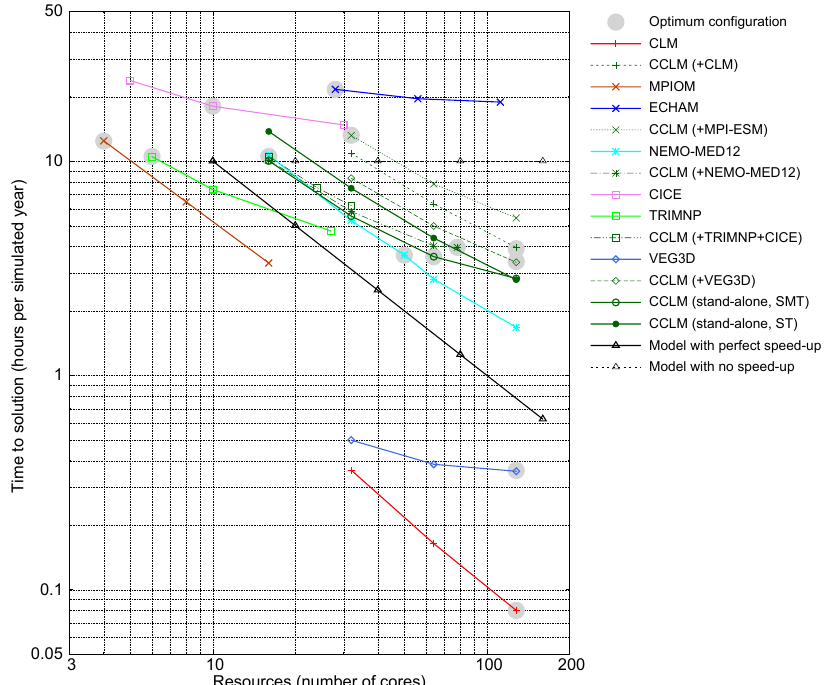
Figure 3. Time to solution of model components of the coupled systems (indicated for CCLM in brackets) and for CCLM stand-alone (CCLM sa ) in hours per simulated year (HPSY) in dependence on the computational resources (number of cores) in single-threading (ST) and multi-threading (SMT) mode. The times for model components ECHAM and MPIOM of MPI-ESM are given separately. The optimum configuration of each component is highlighted by a grey dot. The hypothetical result for a model with perfect and no speed-up is given as